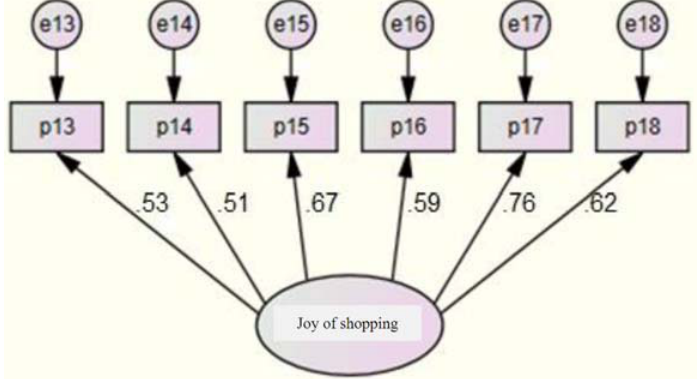
Fig. 3. First-order confirmatory factor analysis for joy of